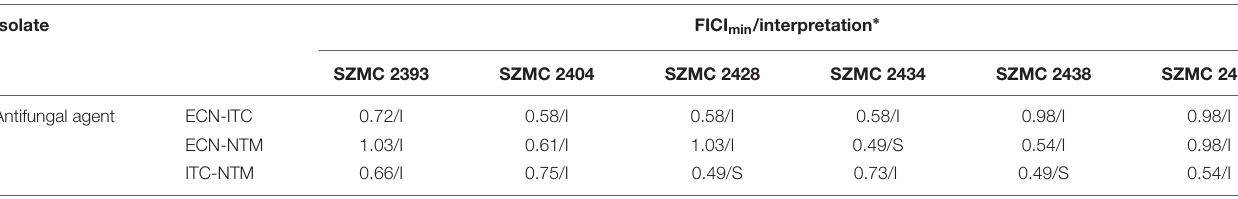
TABLE 4 | In vitro combinations of antifungal drugs against six Aspergillus tamarii isolates from human keratomycosis. Isolate